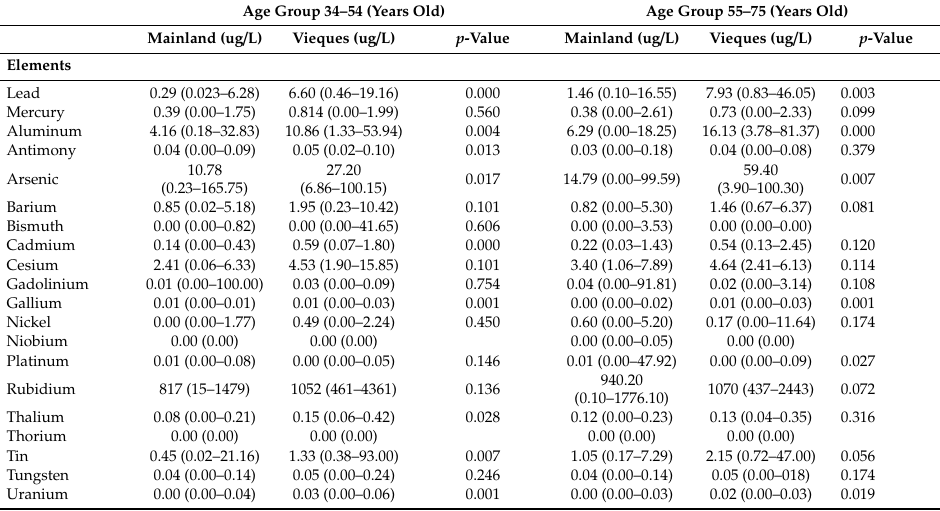
Table 2. Median toxic metal concentrations (range) distributed by age groups 34–54 and 55–74 in Main Island and